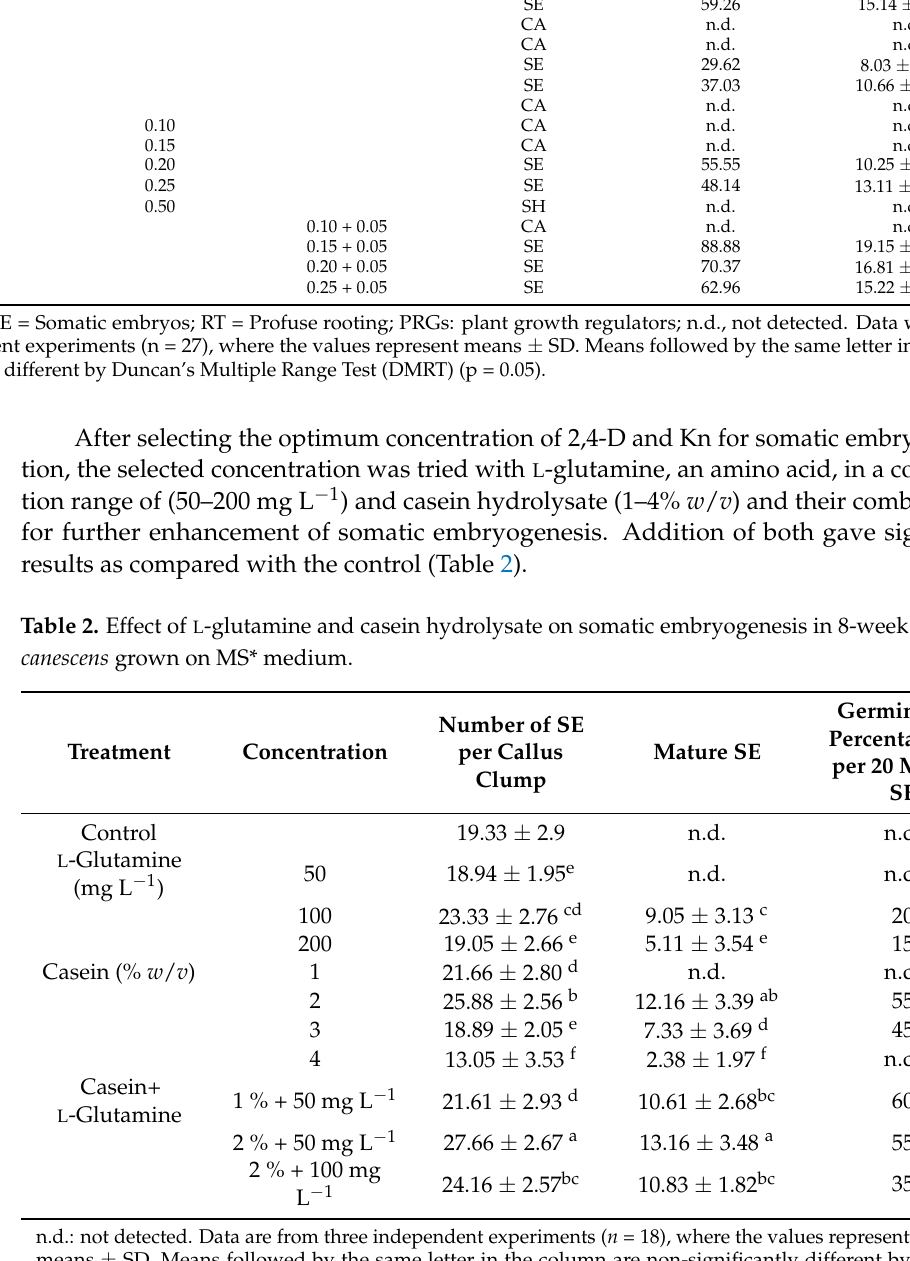
n.d.: not detected. Data are from three independent experiments ( n = 18), where the values represent means ± SD. Means followed by the same letter in the column are non-significantly different